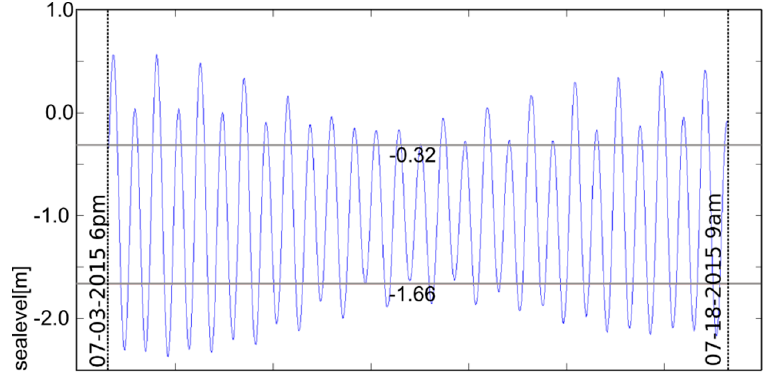
Figure 4. Sea level heights measured by the tide gauge in June 2015. Black lines show the mean high- and low tide values that were used as a reference for the 2 m lower high and low tide around the year 1000.